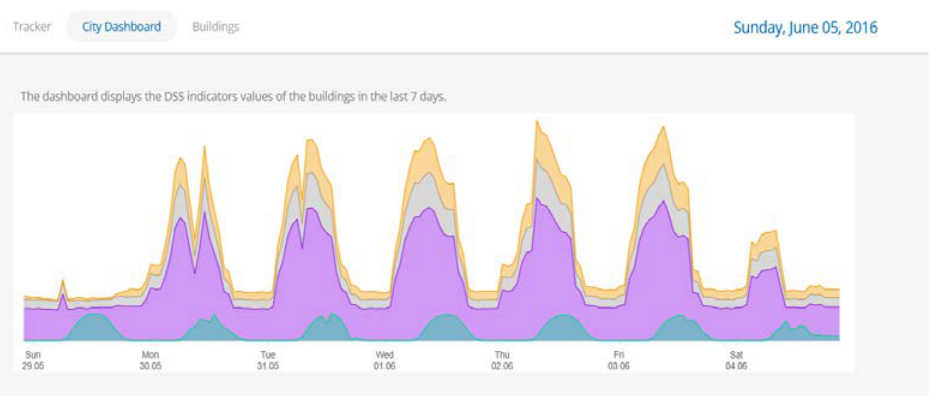
Figure 3. Energy assets.